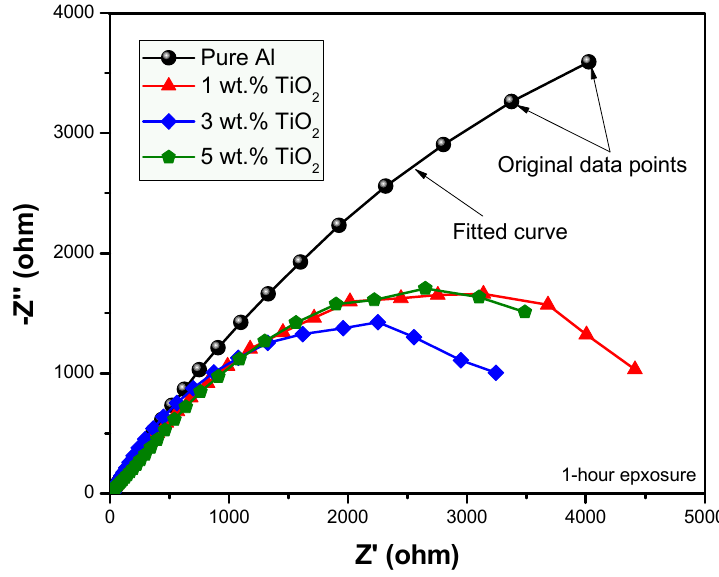
Polymers 2021 , 13 , 4319 Figure 5. EIS for composite samples exposed for 1-h in 3.5% NaCl solution. Figure 5. EIS for composite samples exposed for 1-h in 3.5% NaCl solution.